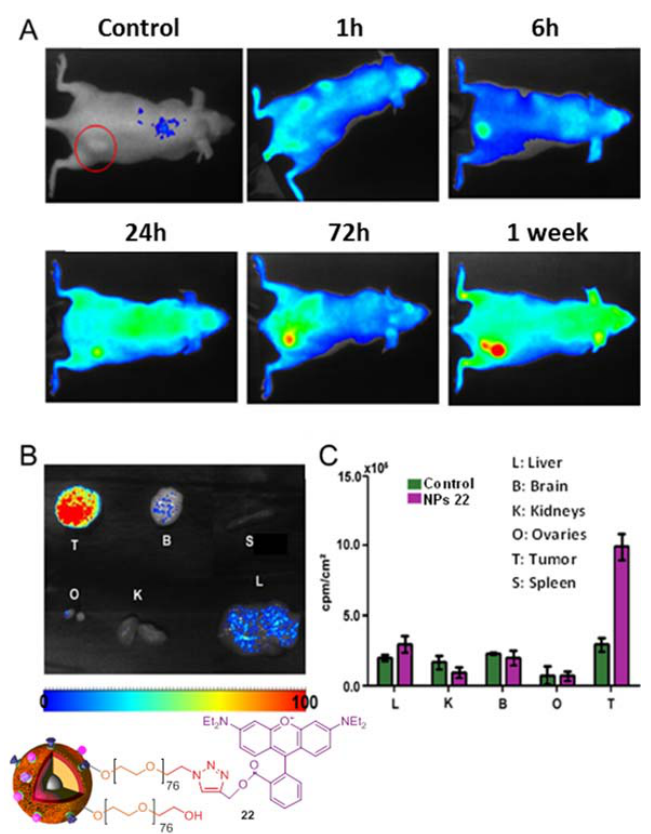
Figure 3. Passive targeting of xenografted tumors by NPs 22 . ( A ) Evolution of fluorescence distribution over time using whole animal imaging. ( B ) Analysis of NPs distribution on isolated organs. ( C ) Quantification of NPs accumulation in tissues over time by measuring fluorescence.